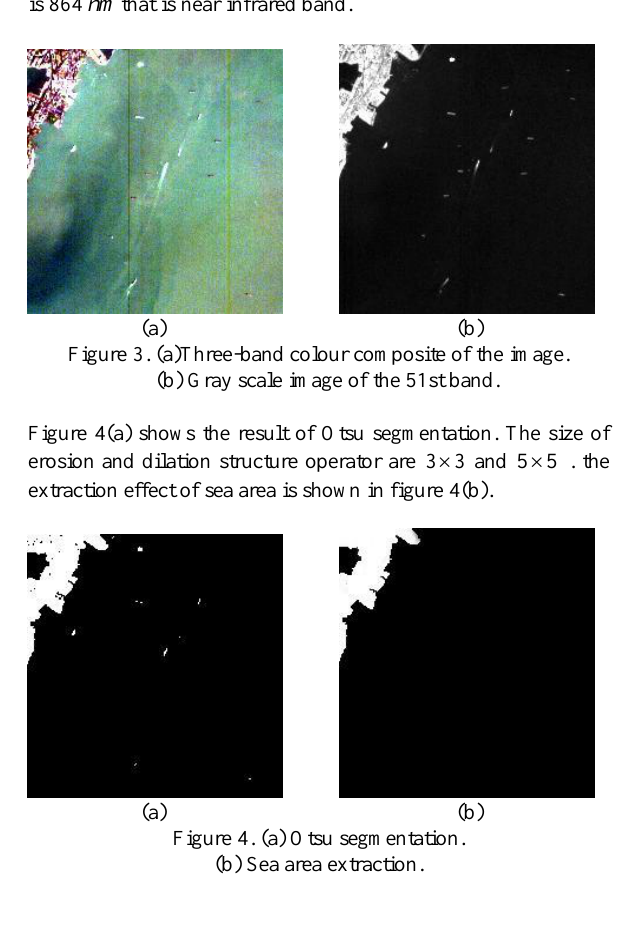
Figure 4. (a) Otsu segmentation. (b) Sea area extraction.